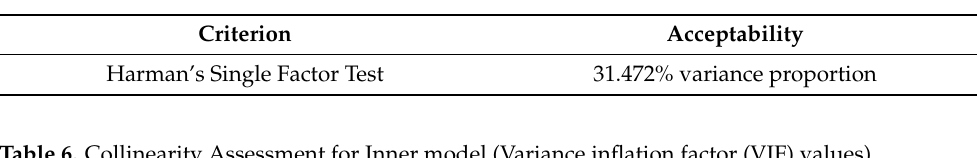
Table 5. Harman’s Single Factor Test.